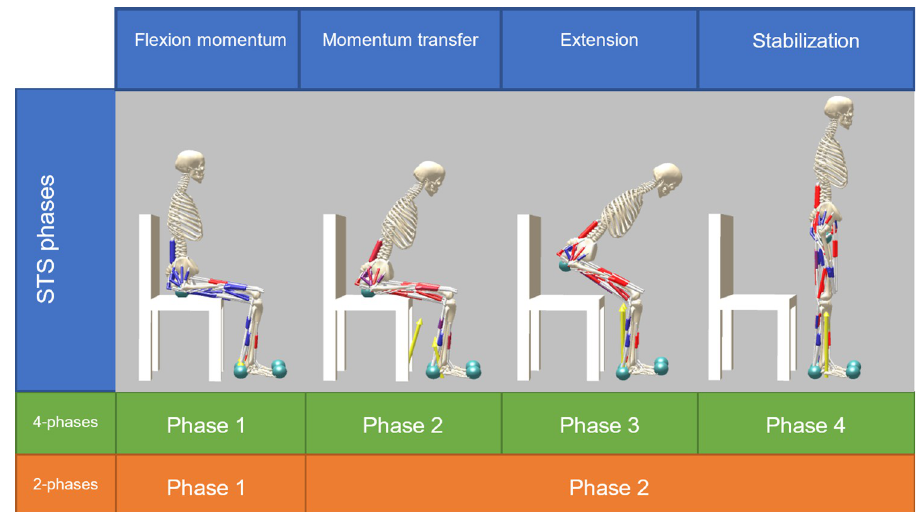
Fig 3. STS cycle described according to their kinematics and to the